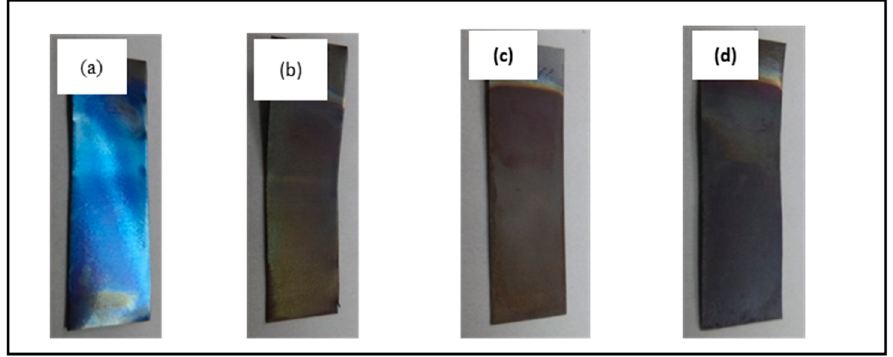
Figure 3. Digital images of physical appearance of Ti foil anodized at ( a ) 30 s; ( b ) 10 min; ( c ) 20 min; and ( d ) 60 min.